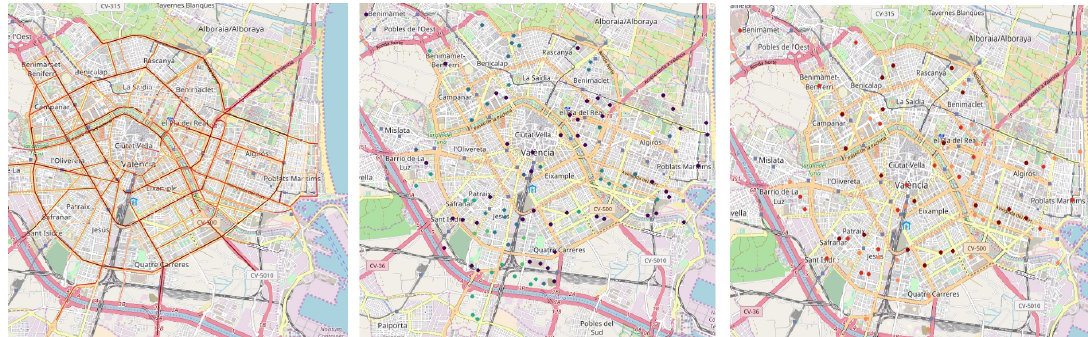
Figure 4. Maps that show the characteristics considered for each charging station.